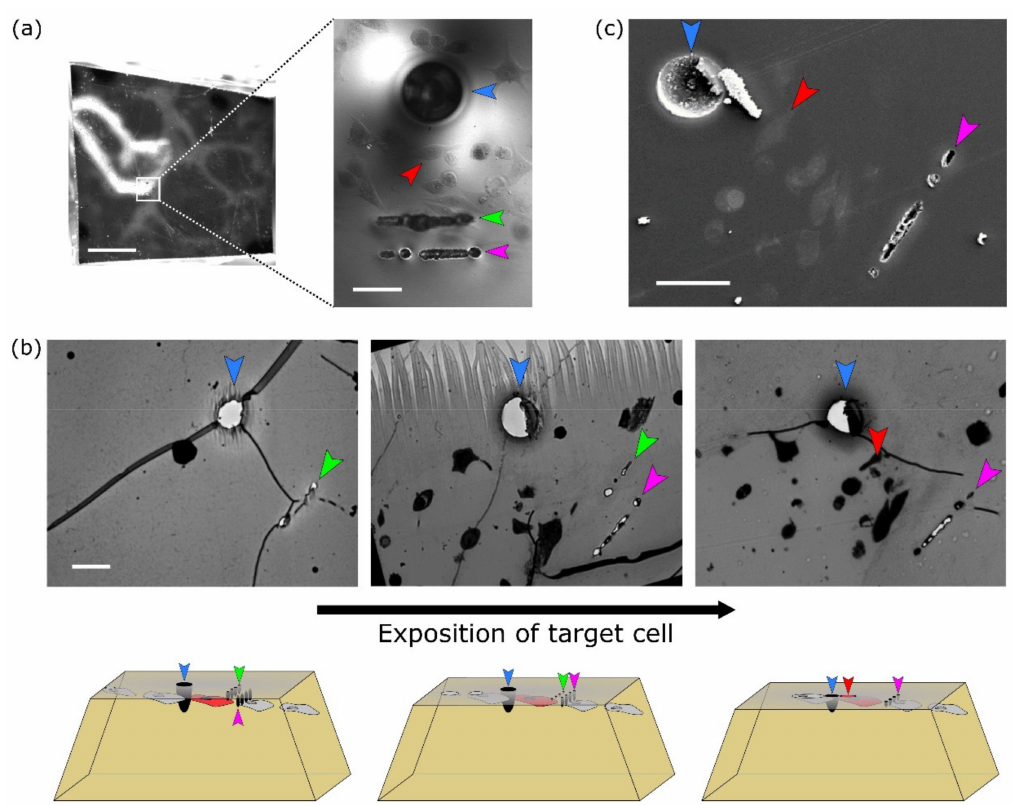
Figure 3. Ultramicrotomy guided by NIRB markers was used for exposition of target cell prior to FIB-SEM imaging. ( a ) Left: Top surface of resin block pyramid before ultramicrotomy trimming; Right: Magnified view of region of interest showing target cell (red arrowhead) and markers for orientation in XY (big bubble, blue arrowhead) and Z-lines (two sets of markers with different depths in Z, green and magenta arrowheads). Readers should note the out of focus green line located closer to the trimmed surface. Scale bar 1 mm (left), 50 µ m (right). ( b ) Top row: Toluidine blue-stained ultramicrotomy sections show stepwise Z-line marker appearance. Note the simultaneous exposure of the target cell and disappearance of the green Z -axis marker on the right-most slice. Bottom row: Illustration of target cell exposition. Upward pointing magenta arrowhead in the leftmost image marks a not yet exposed Z-line. Arrowhead colour code same as ( a ). Scale bar 50 µ m. ( c ) Exposed target cell and both XY and Z-line markers as seen by SEM prior to milling of the trench for FIB-SEM imaging. Arrowhead colour code as ( a ). Scale bar 50 µ